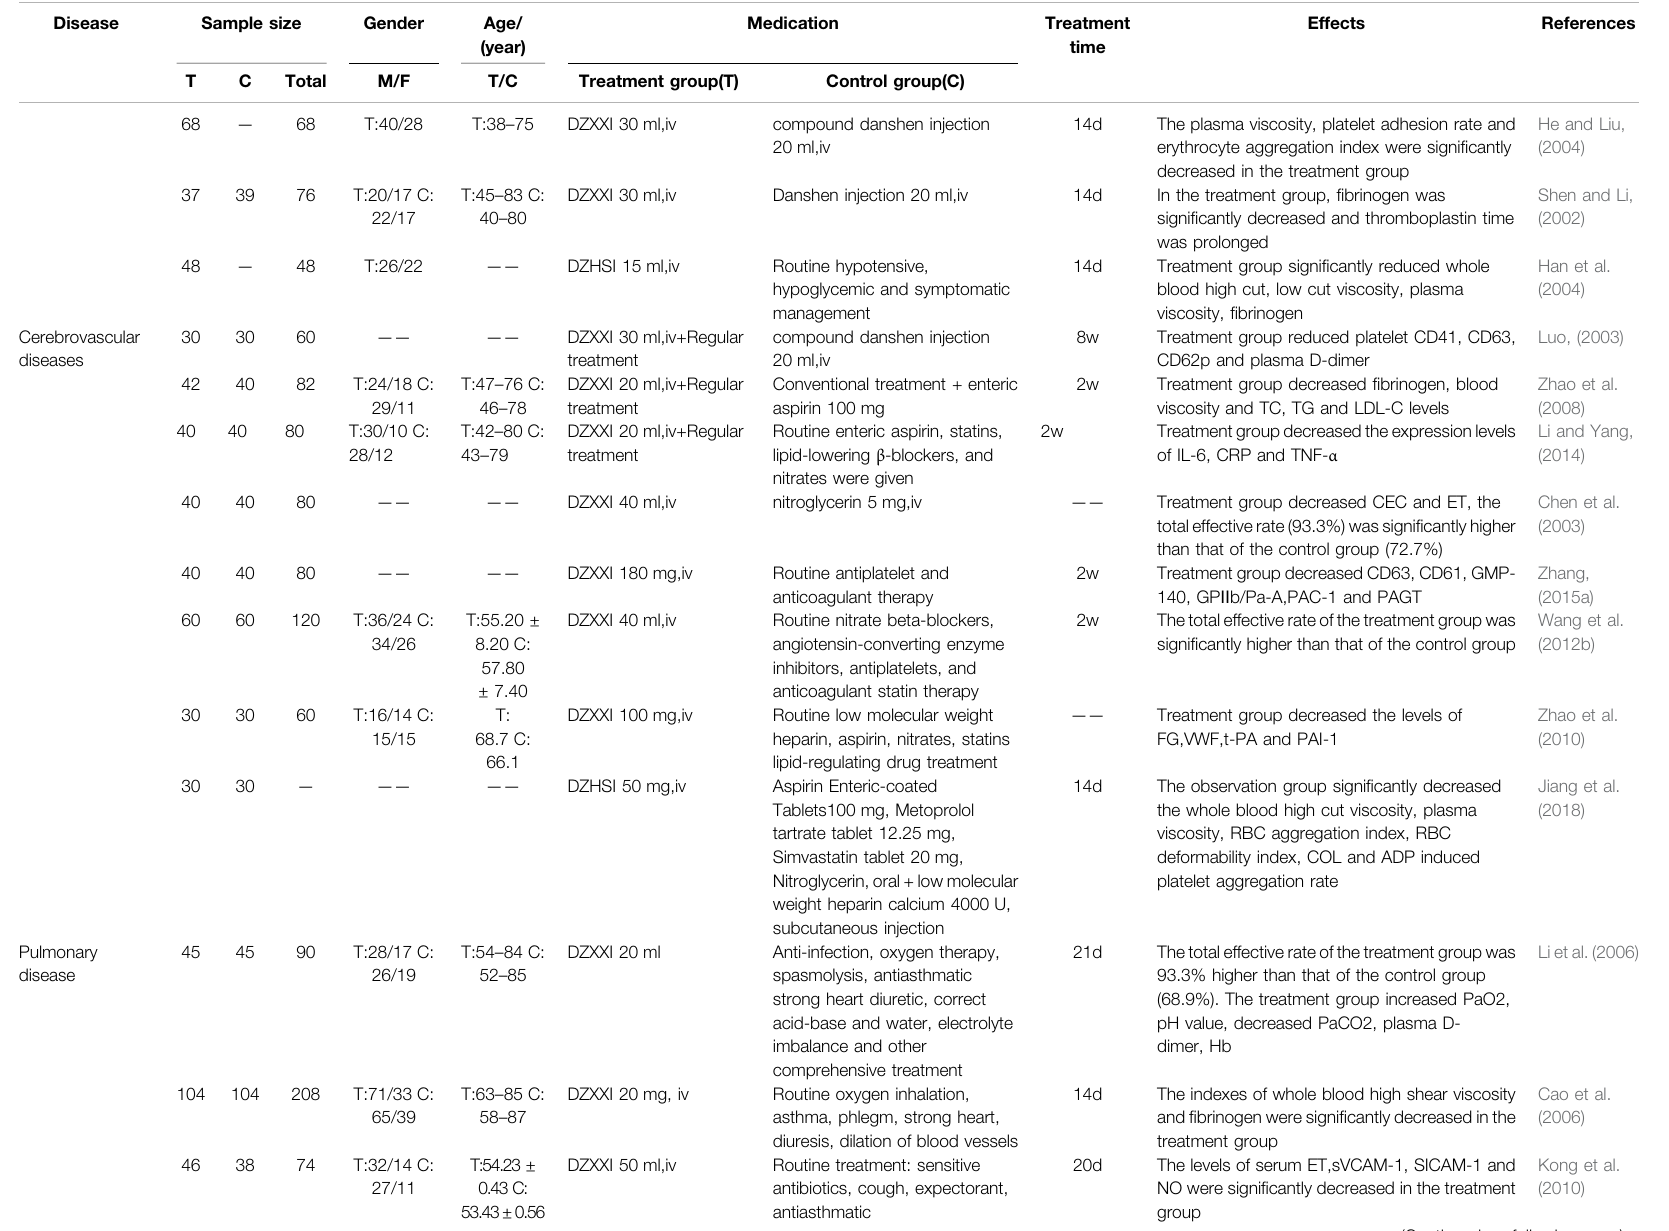
Treatment group decreased the levels of FG,VWF,t-PA and PAI-1 The observation group signi fi cantly decreased the whole blood high cut viscosity, plasma viscosity, RBC aggregation index, RBC deformability index, COL and ADP induced platelet aggregation rate